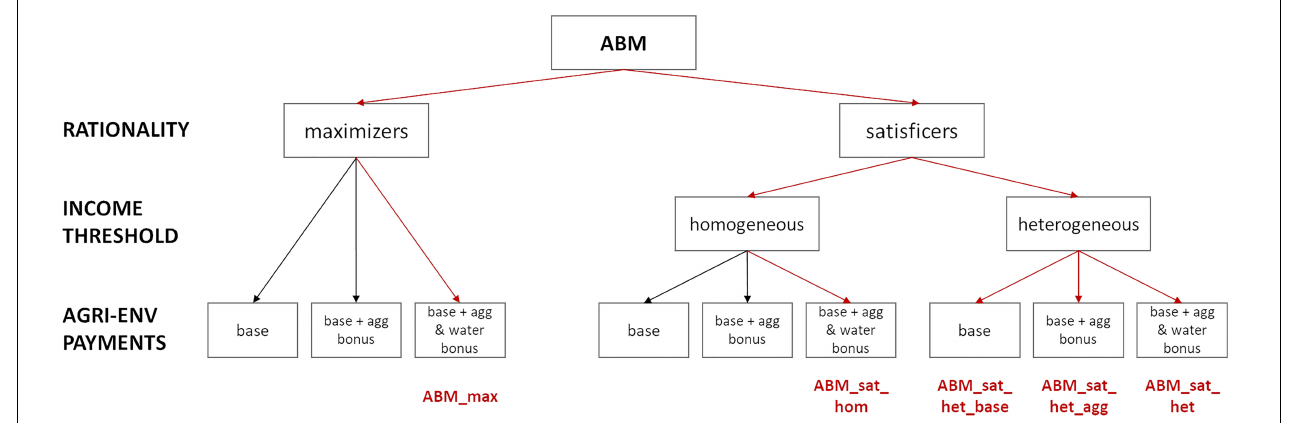
FIGURE 3 | Overview of the different ABM variants. Those that were used in the comparison with CoMOLA are marked with red arrows and include the respective abbreviation.